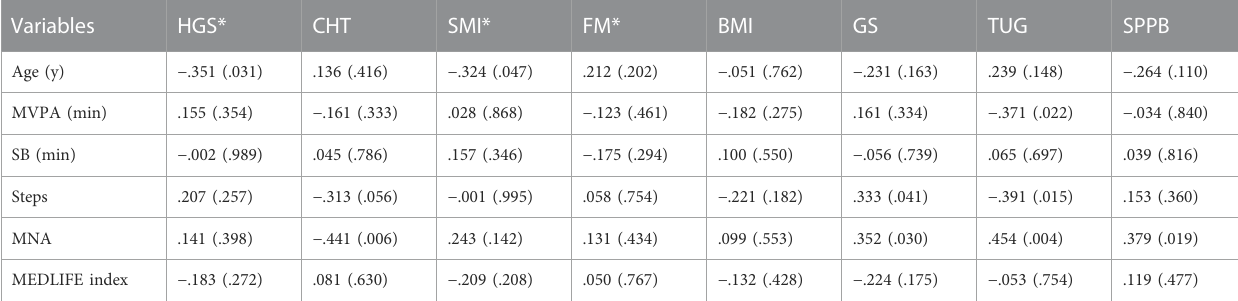
TABLE 3 Pearson ’ s and Spearman ’ s (*) correlation between sarcopenia and obesity parameters and selected behavioral variables. A Pearson ’ s r and Spearman ’ s rho ( p -value) is reported. Variables